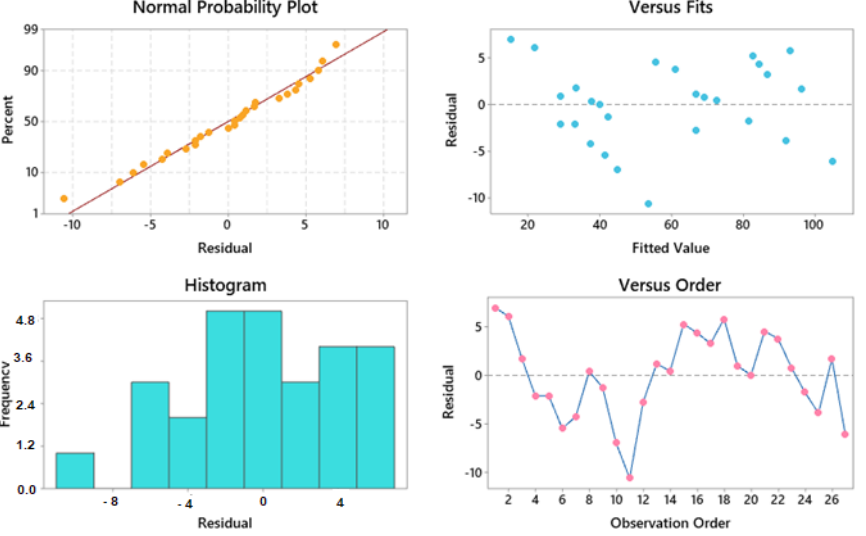
Figure 7. Residual plots for conversion of GA (geraniol) (mol%).